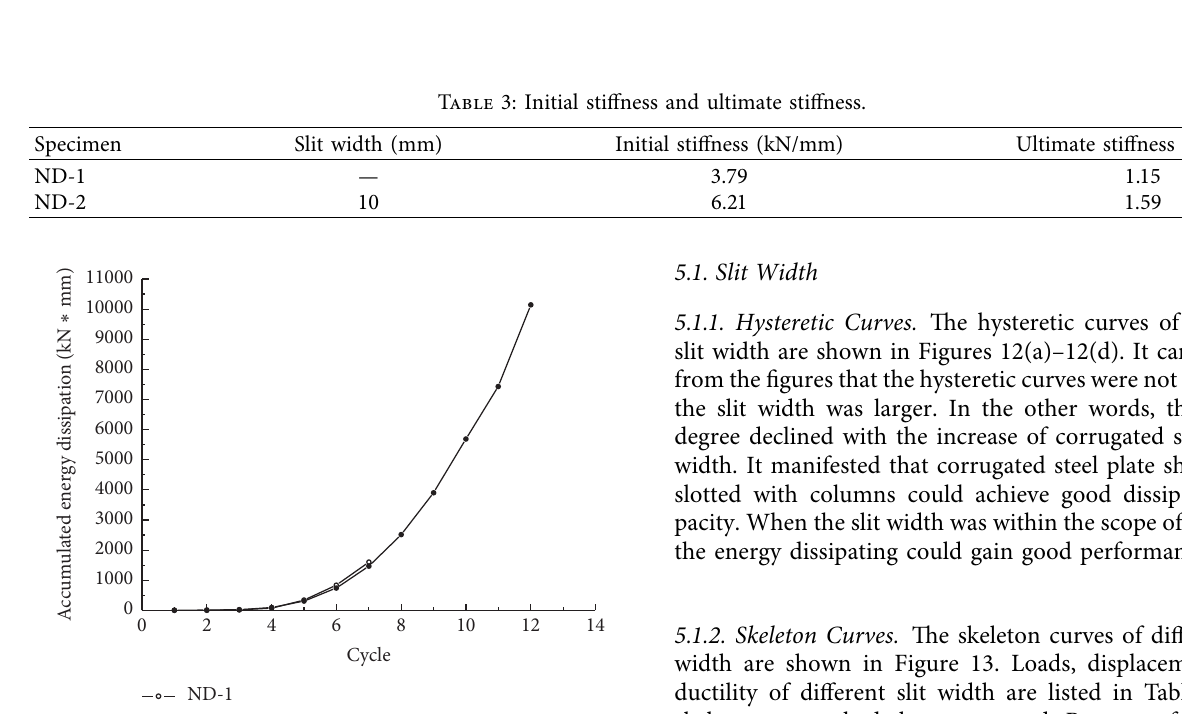
Figure 10: Stiffness curves.